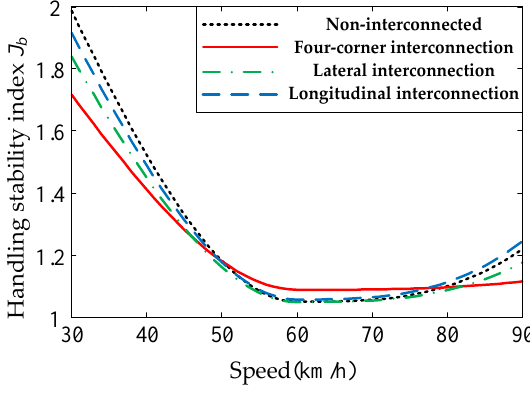
Figure 7. Handling stability index J b under the steering condition.